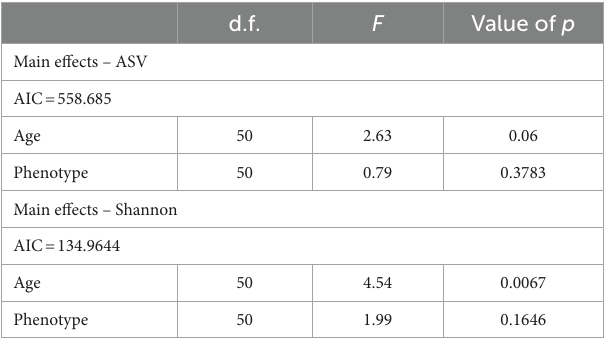
TABLE 1 Linear mixed-effects model by restricted maximum likelihood (REML) for alpha diversity of ASV and Shannon indices in Bombus terrestris